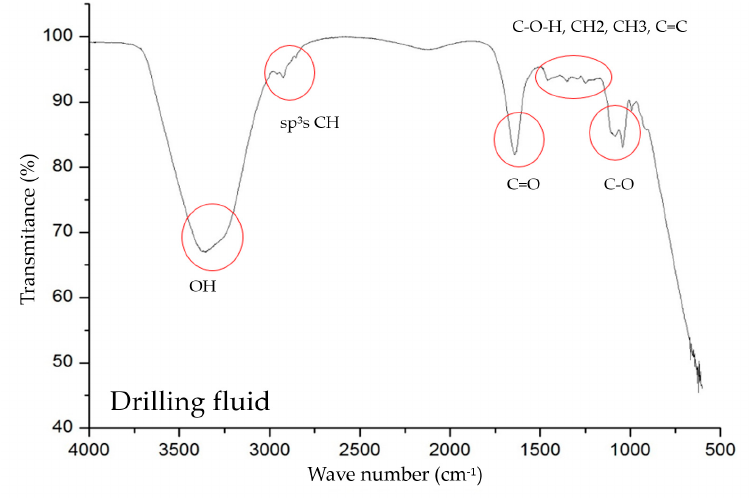
Figure 13. Absorption spectrum in the infrared region of the drilling fluid.